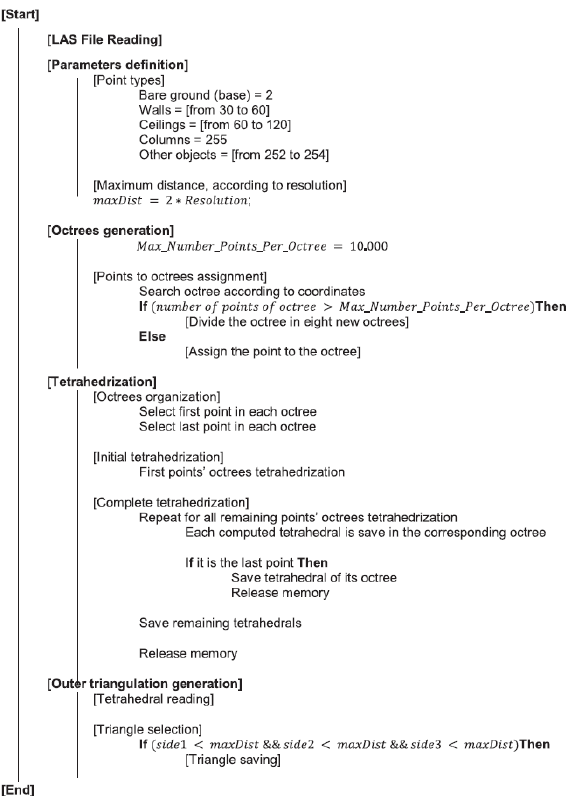
Figure 4. Pseudocode of the tetrahedrization